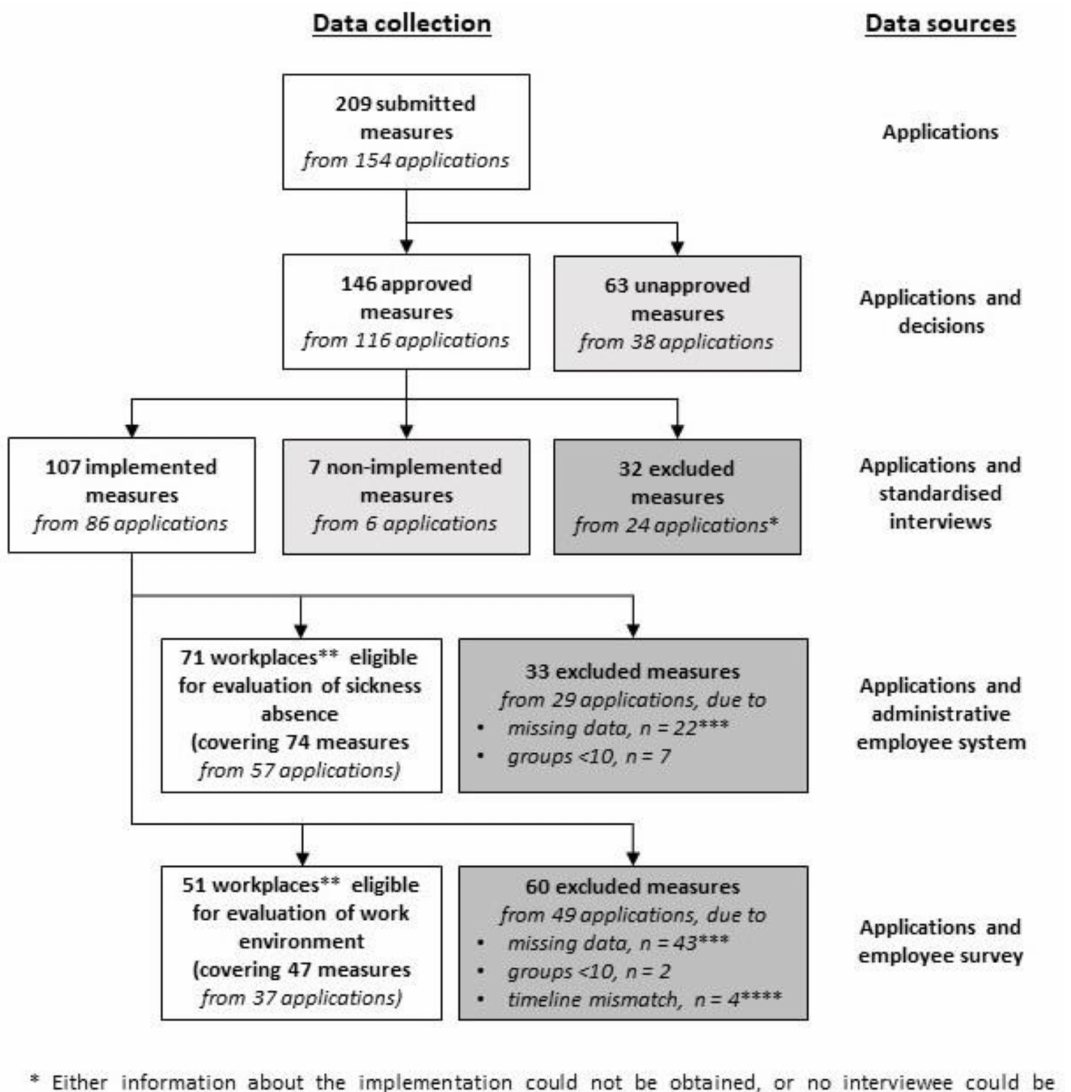
Figure 2. Flowchart describing the different steps in the data collection and the data sources used for each step, together with the number of measures, applications, and workplaces in each